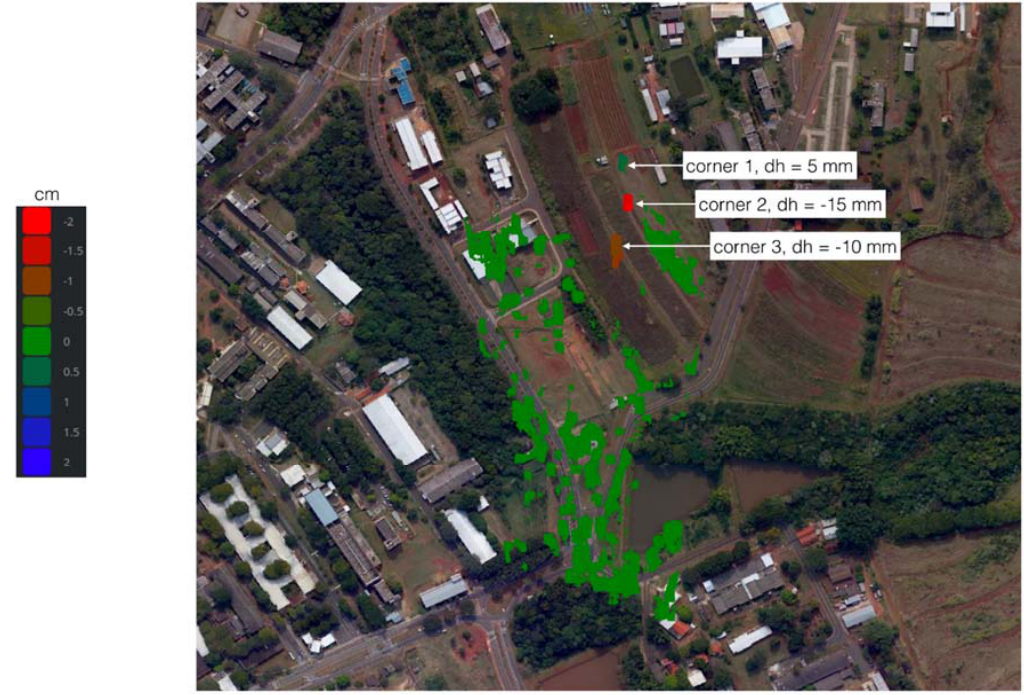
Figure 5. Deformation map of the interferogram 1 and 3—from the first and the third flights. Displacement is positive (dh > 0) when terrain height decreases with time. The coherence threshold is 0.75. Corner reflector 2 was lifted 2 cm in the second flight. The measured displacement was ‐ 15 mm.